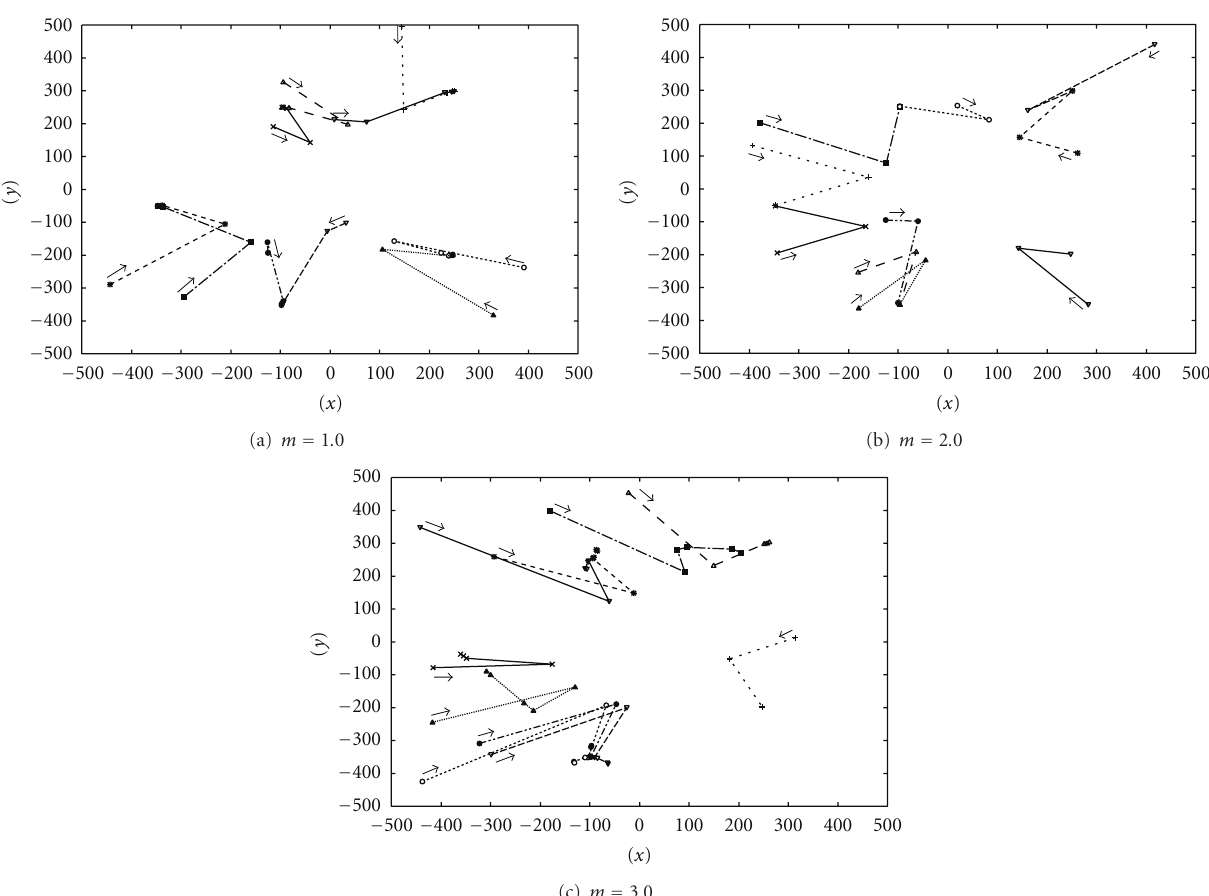
Figure 7: The shifts of cluster centers of Shannon entropy based clustering with decreasing the temperature by VFA ( m = 1 . 0,2 . 0,3 .